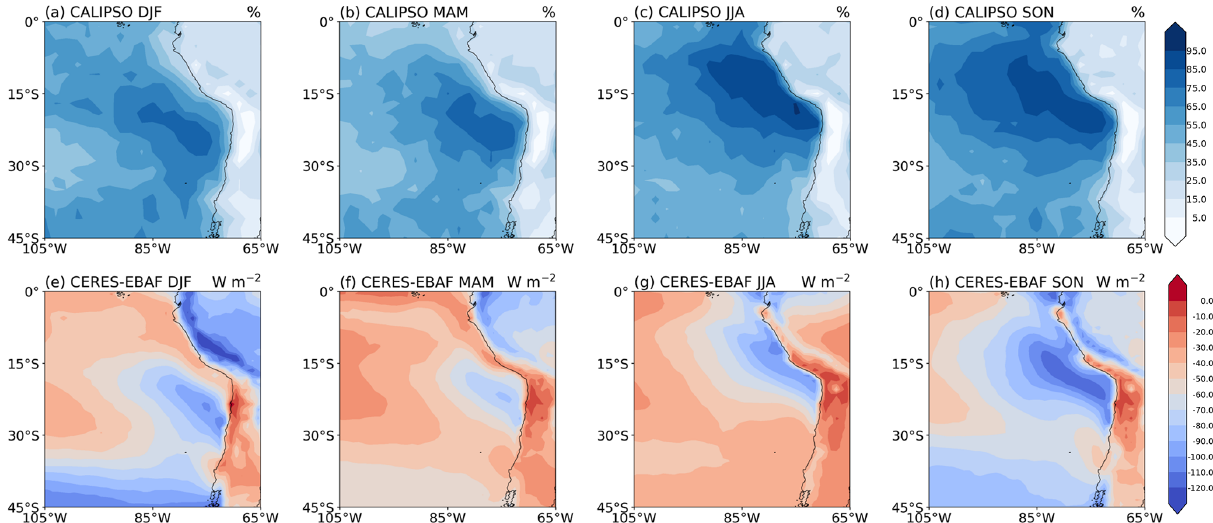
Figure 11. Observed low-level cloud amount from CALIPSO (a–d) and shortwave cloud radiative effect from CERES-EBAF (e–h) , averaged over December, January, and February (DJF; a, e ), March, April, and May (MAM; b, f ), June, July, and August (JJA; c, g ), and September, October, and November (SON; d, h